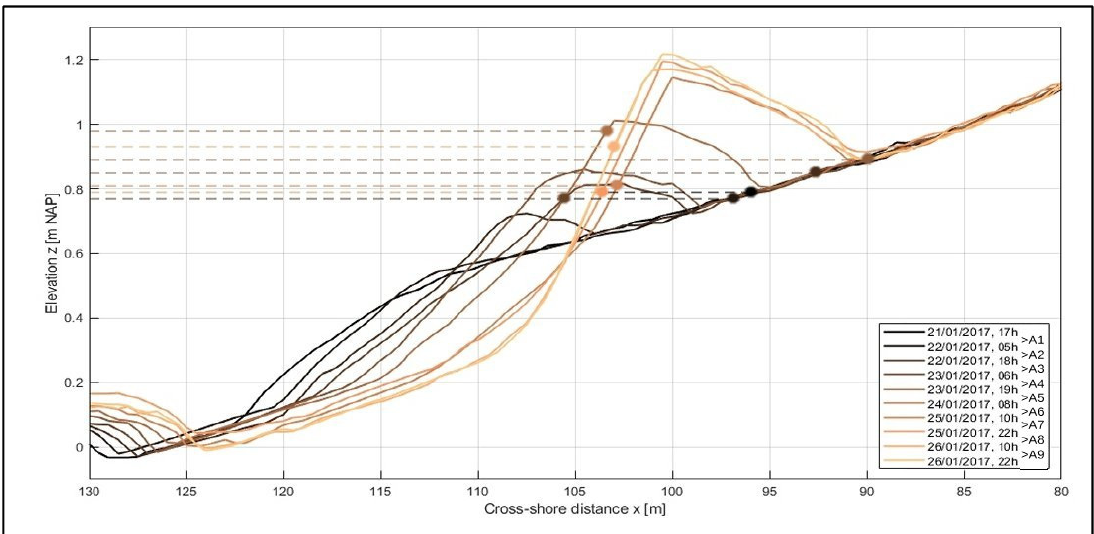
Figure 9 . Low waterbed levels for period A (M1 in Figure 7) from 21 to 26 January 2017. The dashed lines indicate the total high water level after each subsequent low water period. A1–A9 indicates time periods shown in Figure 10.